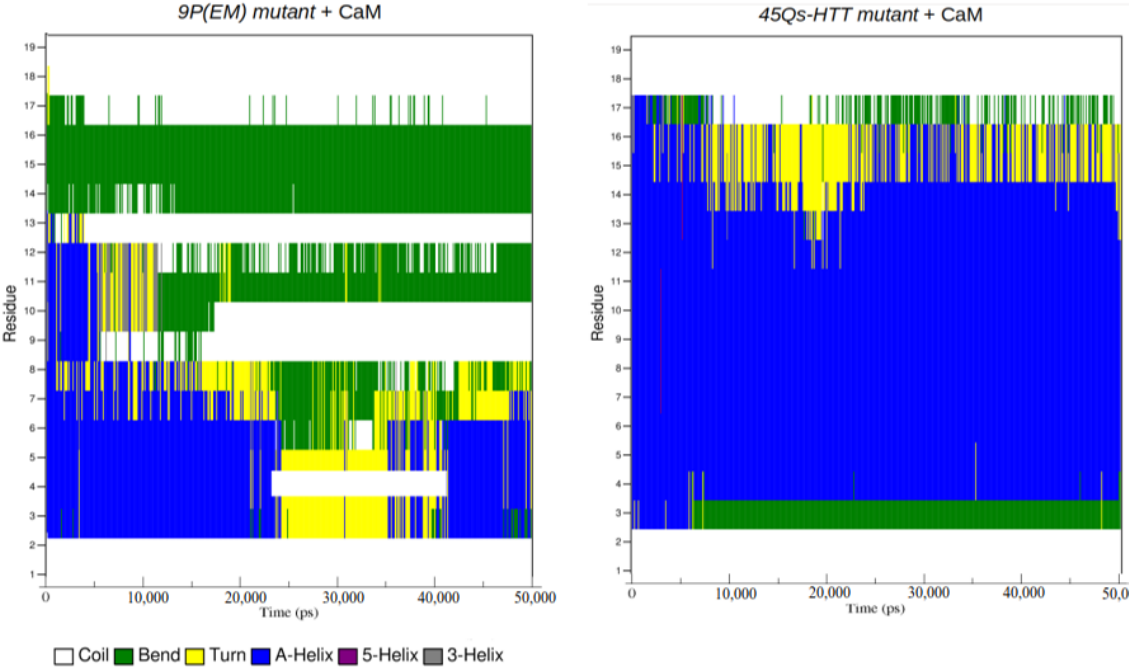
Figure 11. DSSP plots for secondary structure transitions between residue numbers 15 and 33 for the two mutant HTT models.